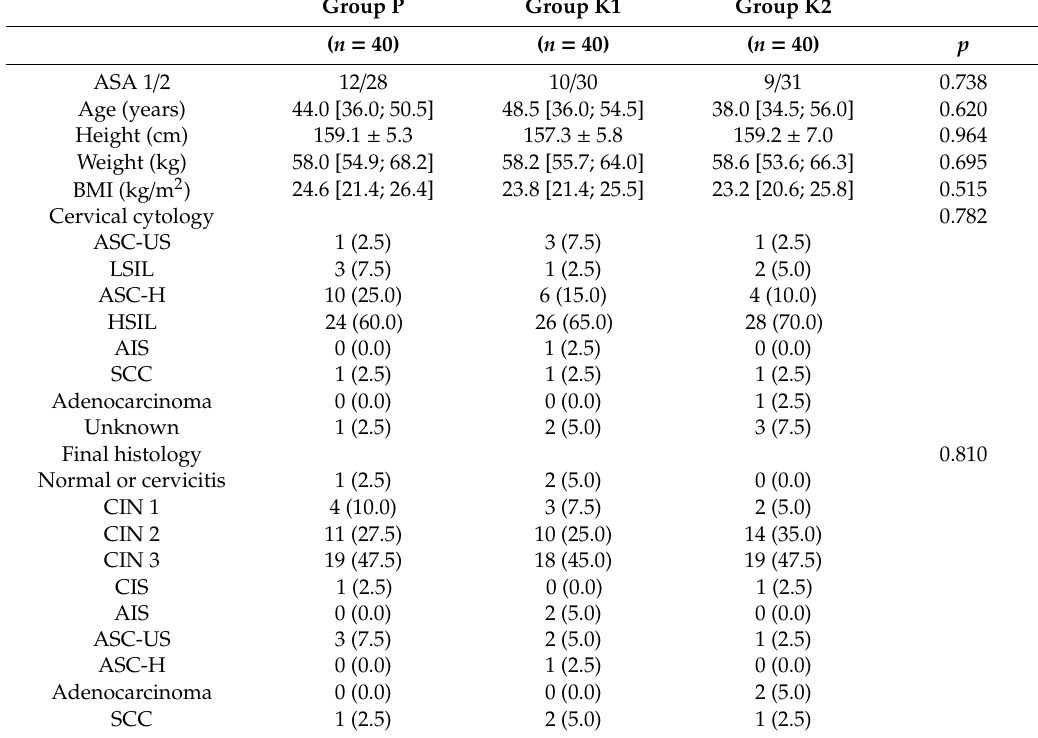
Table 1. Patient characteristics and cervical pathologies.